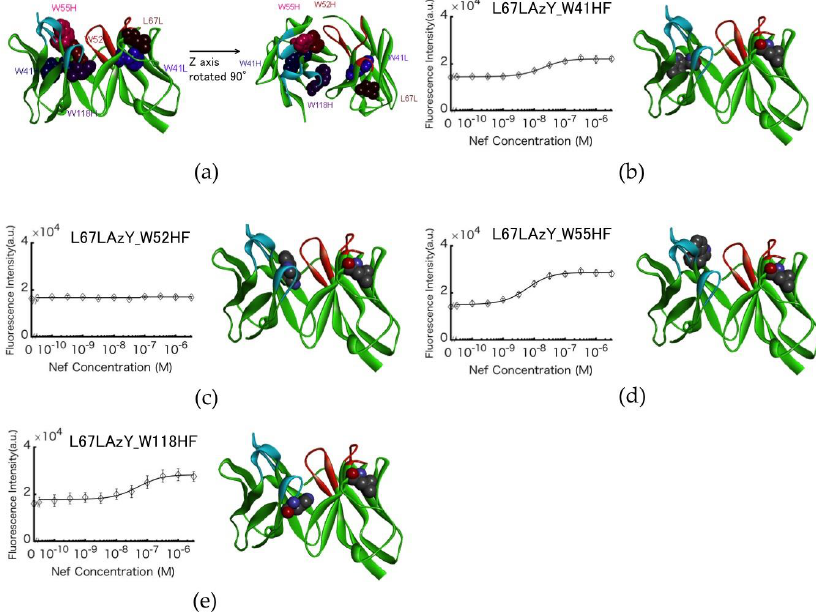
Figure 5. Antigen-dependent enhancement of Nef Q-body fluorescence. ( a ) Position of the mutated residues of the anti-Nef antibody. ( b – e ) Schematic illustration of the structure of the Nef Q-body (right). Titration curves of the normalized fluorescence intensity of the Nef Q-body (left). Error bars represent ±1 S.D. (n = 3).